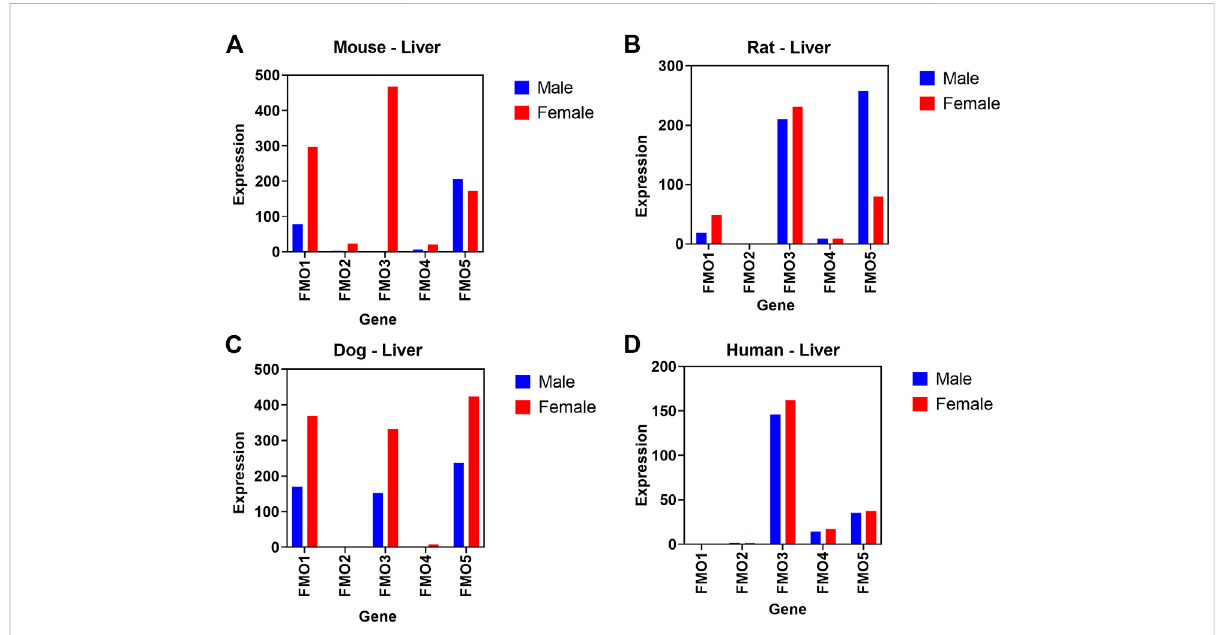
FIGURE 7 Relative difference in transcript level expression of Flavin-containing monooxygenases (FMO) genes. Sex differences between male (blue) and female (red) are shown across 5 different FMO isoforms in mouse (A) , rat (B) , dog (C) , and (D) human liver.